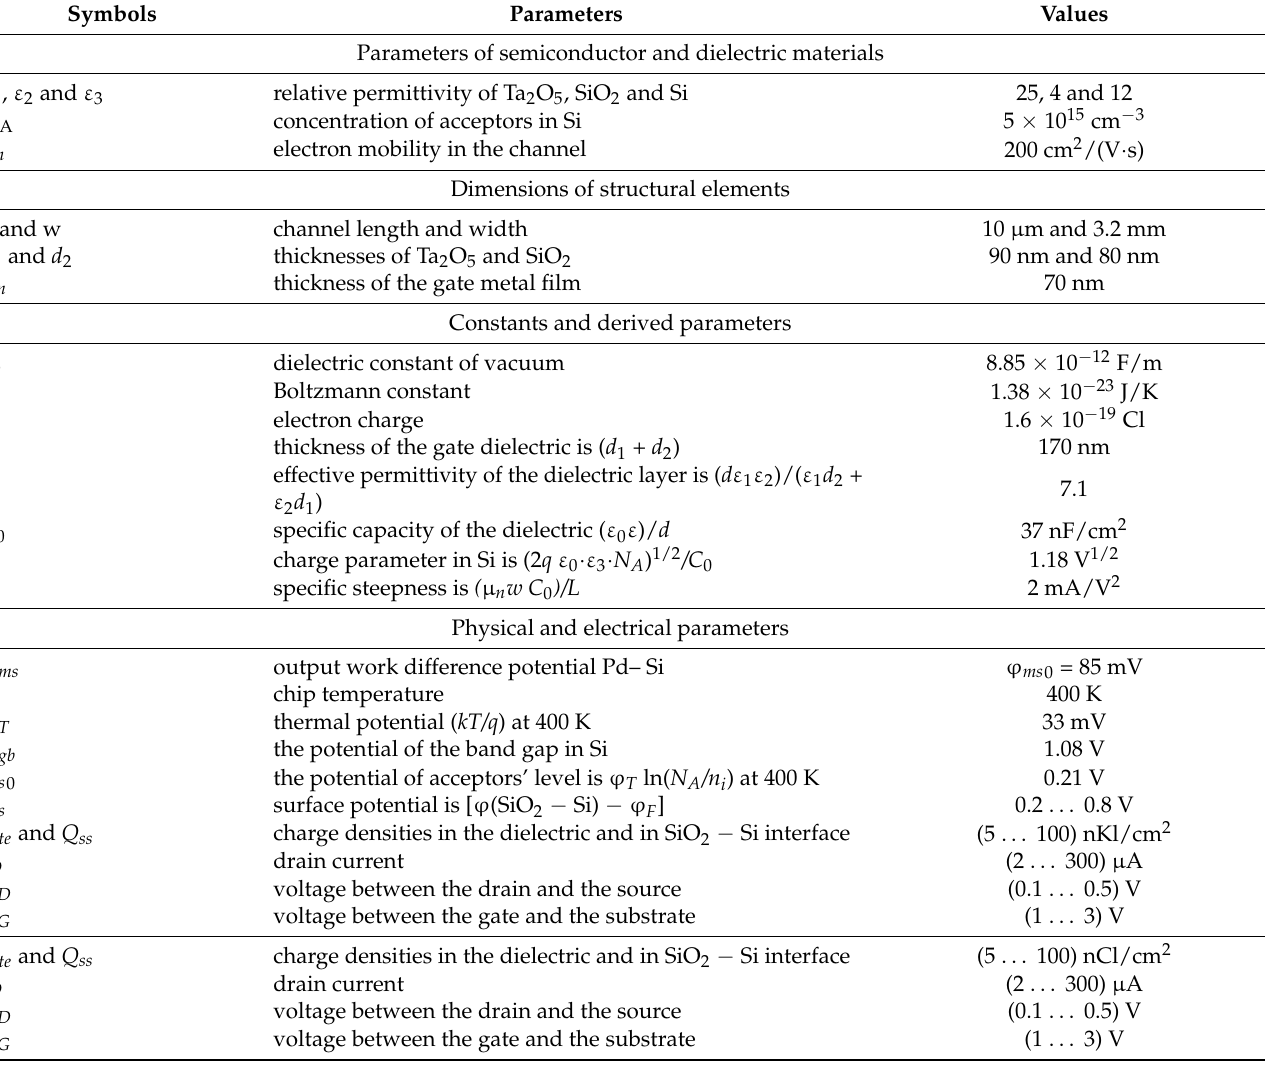
Table 1. Average values of the parameters of MISFETs and parameters of used models. Symbols Parameters Values Parameters of semiconductor and dielectric